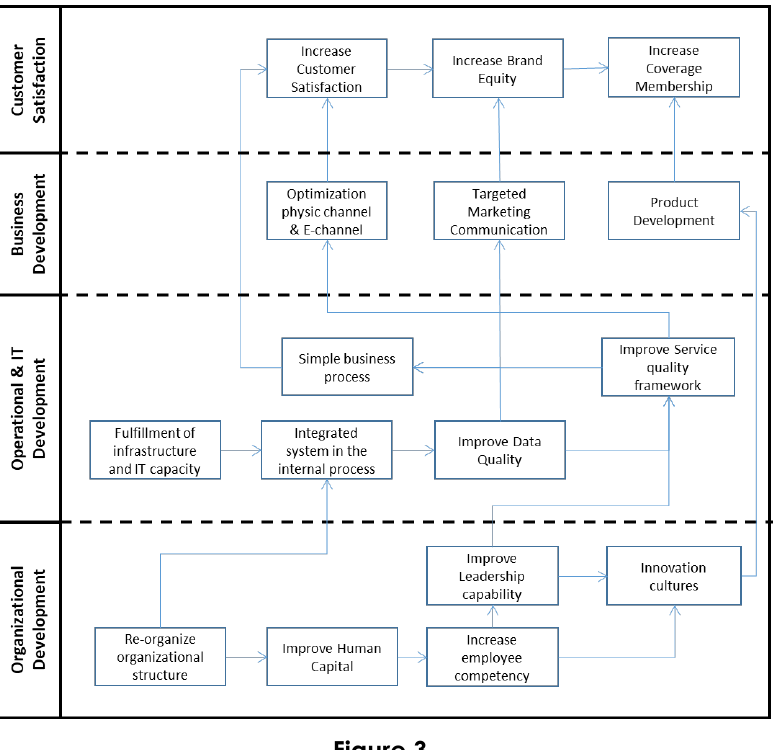
Figure 3. Strategy Map of BPJS